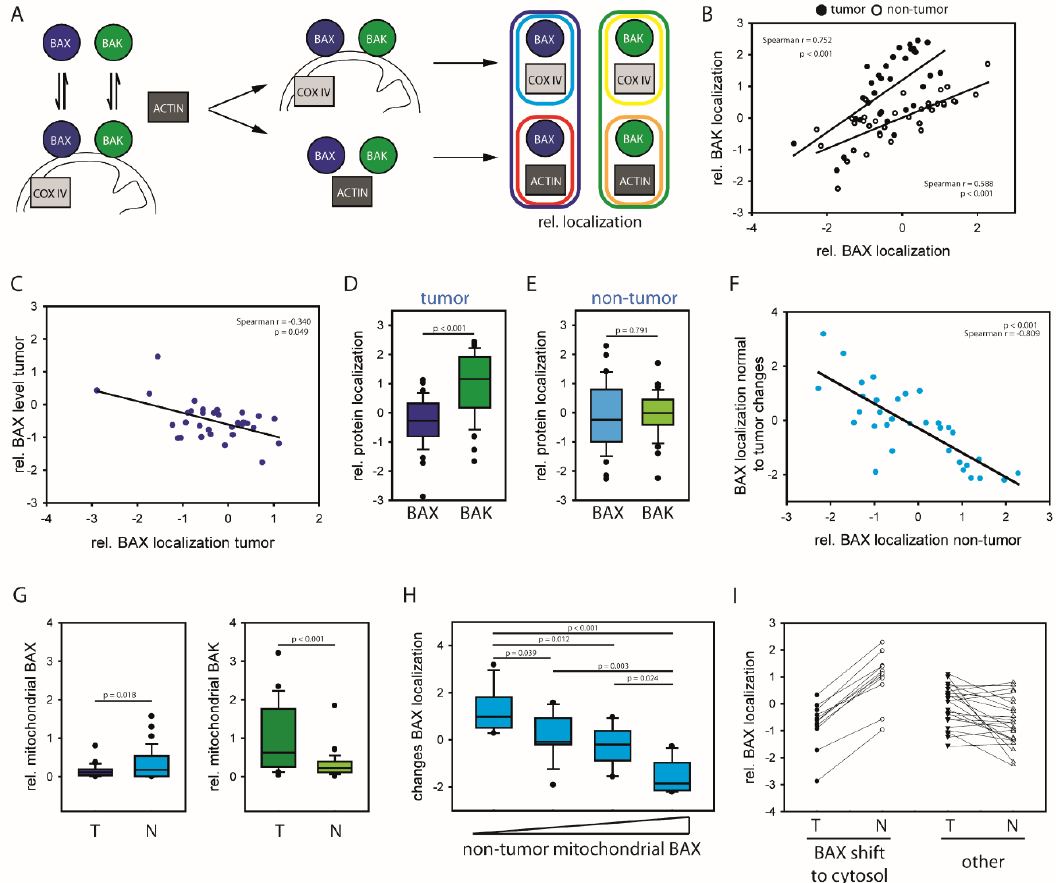
Figure 1. ( A ) BAX and BAK constantly translocate to the mitochondria and retrotranslocate back into the cytosol. Localization equilibriums are characterized by determining relative mitochondrial protein (rel. mitochondrial BAX (cyan), mitochondrial BAX (blue circle) per COX IV (light gray rectangle), rel. mitochondrial BAK (yellow), mitochondrial BAK (green circle) per COX IV (light gray rectangle)), and relative cytosolic protein (rel. cytosolic BAX (red), combining cytosolic BAX (blue cycle) with β -ACTIN (dark gray rectangle); rel. cytosolic BAK (orange), combining cytosolic BAK (green cycle) with β -ACTIN (dark gray rectangle)). Relative protein localization (BAX: blue; BAK: green) is the quotient of relative mitochondrial protein and relative cytosolic protein. High relative protein localization values indicate shift towards the mitochondria independent of the cellular protein concentration. ( B ) Relative BAX localization vs. relative BAK localization (double log10 scale) for 34 HCC patient samples (full circle) and corresponding non-tumor samples (open circle). R- and p -values according Pearson’s correlations. ( C ) Relative BAX localization in tumor tissue vs. relative BAX level in tumor samples (double